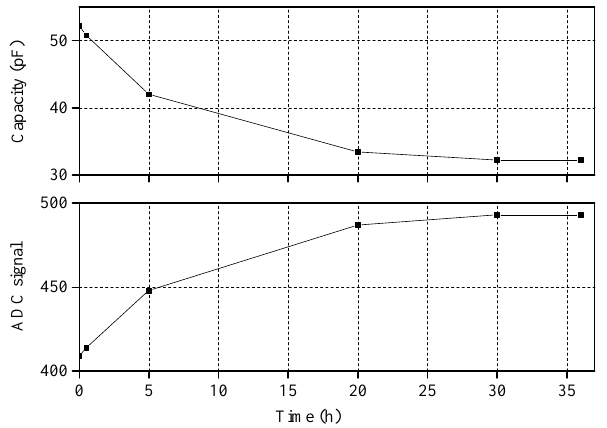
Figure 13. Measured capacity and corresponding ADC values from RFID transponder for a sensor with linseed oil (293K, 0% rel. humidity) for a structure diameter of 3mm.